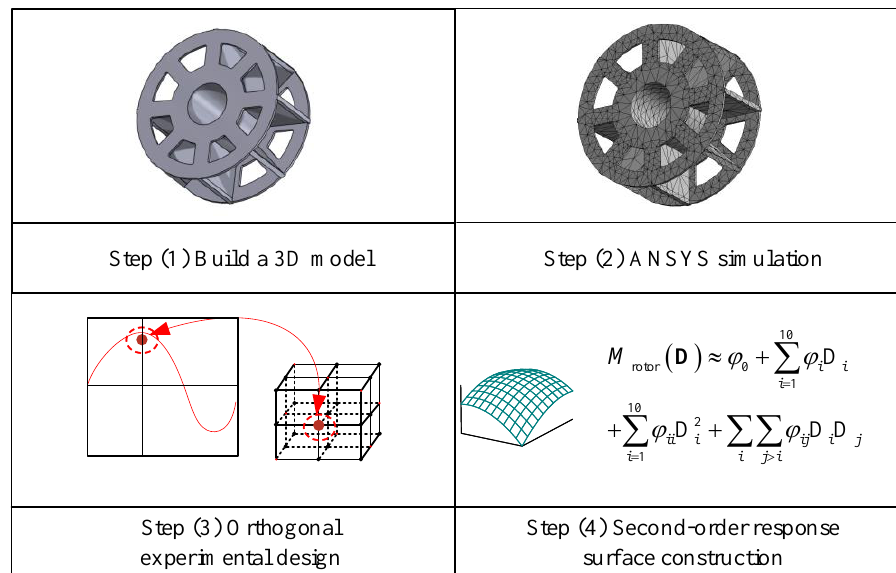
Figure 11. Orthogonal test process and response surface construction of the rotor.